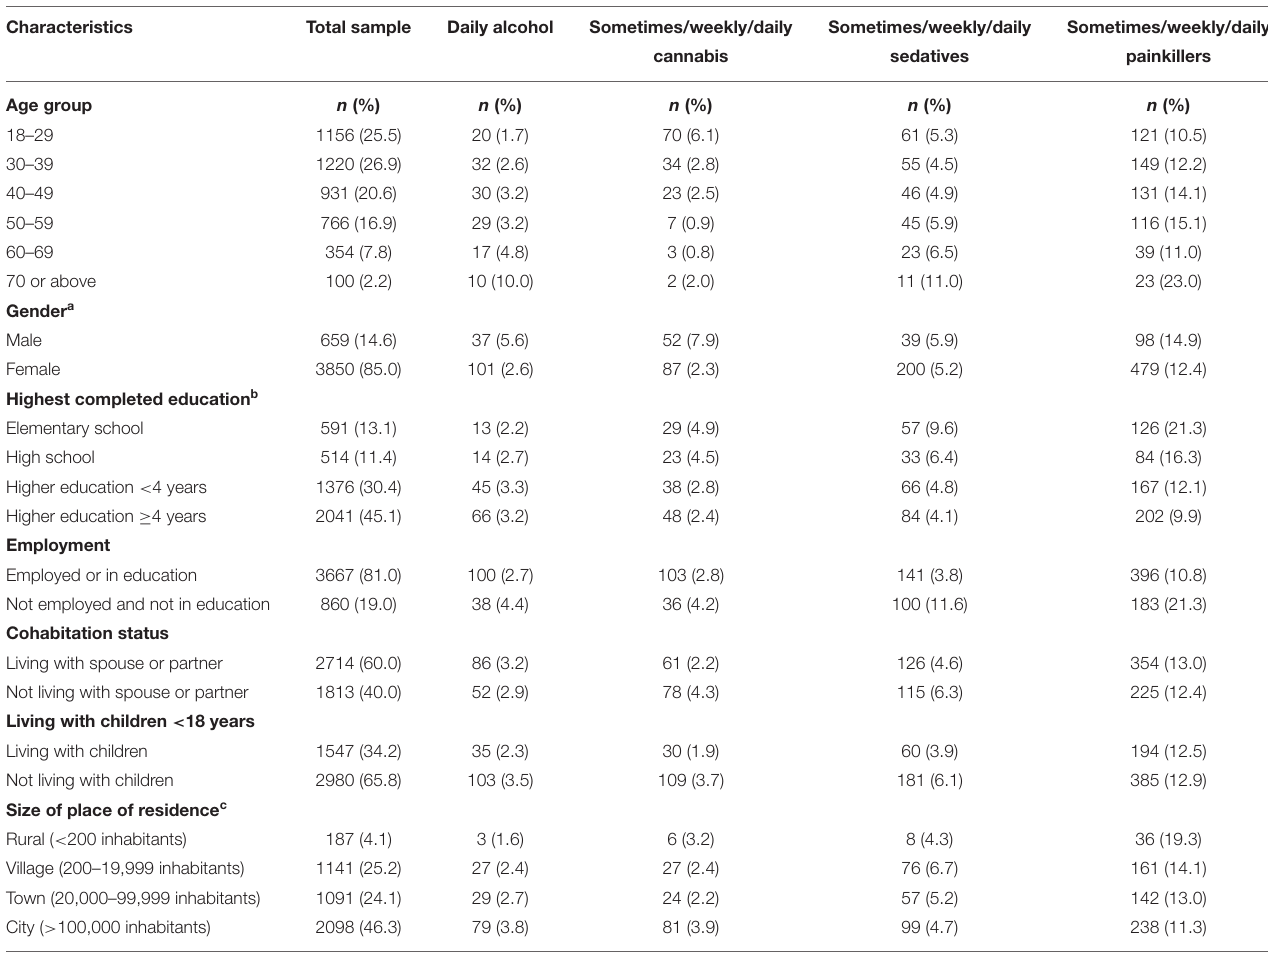
TABLE 1 | Sociodemographic characteristics of the sample ( n = 4,527), among daily users of alcohol ( n = 138) and among sometimes/weekly/daily users of cannabis ( n = 139), sedatives ( n = 241), and painkillers ( n = 579).